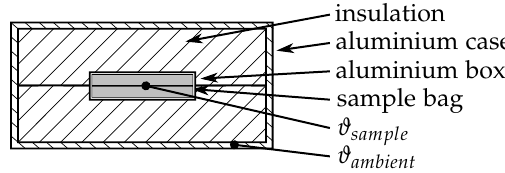
Figure 2: Sketch of the LFA sample holder.